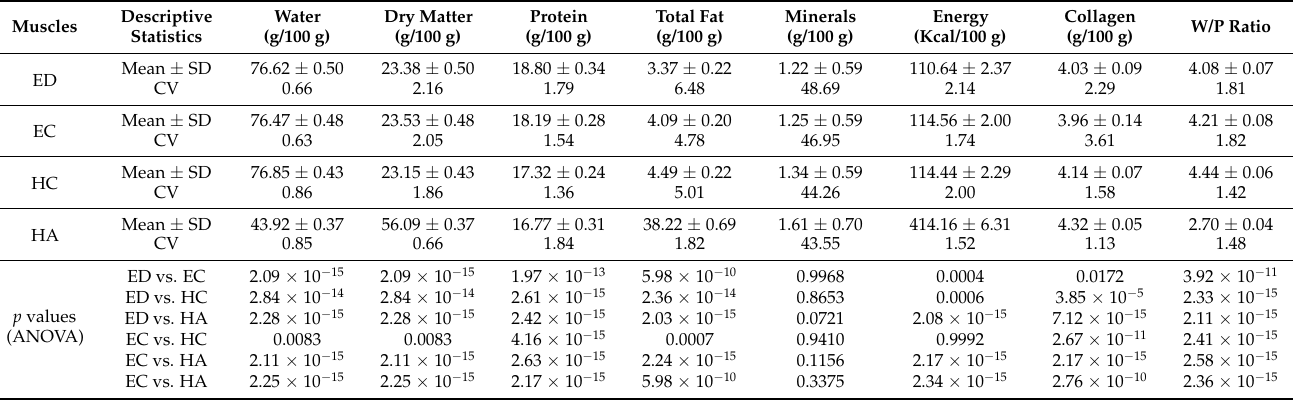
Table 5. Chemical composition and certain nutritional features of Polyodon spathula meat, aged three summers.